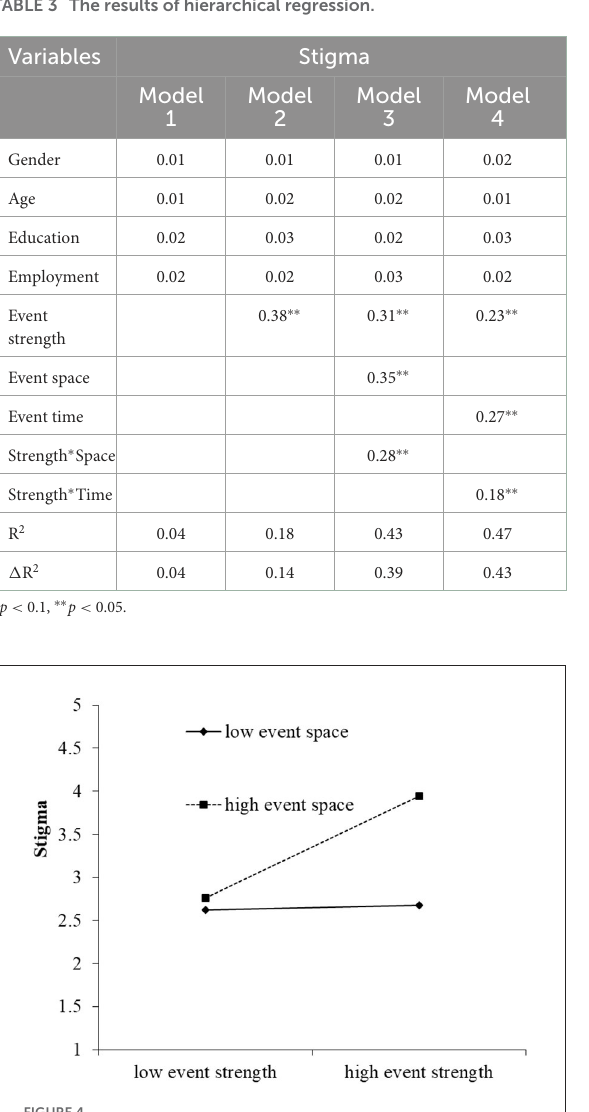
TABLE 3 The results of hierarchical regression.